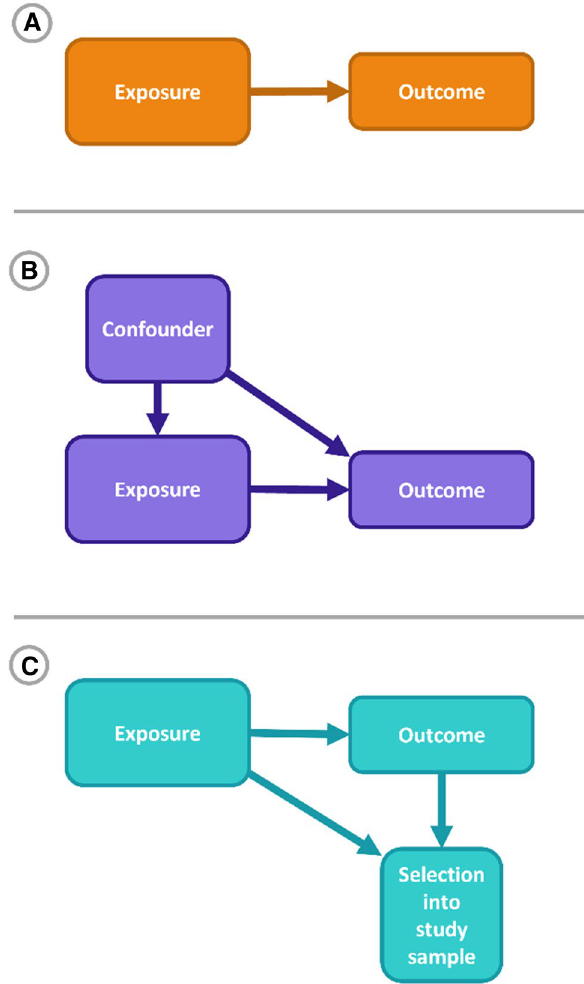
Fig. 2 Illustrative causal diagrams (Directed Acyclic Graphs) for exposure-out- come associations in